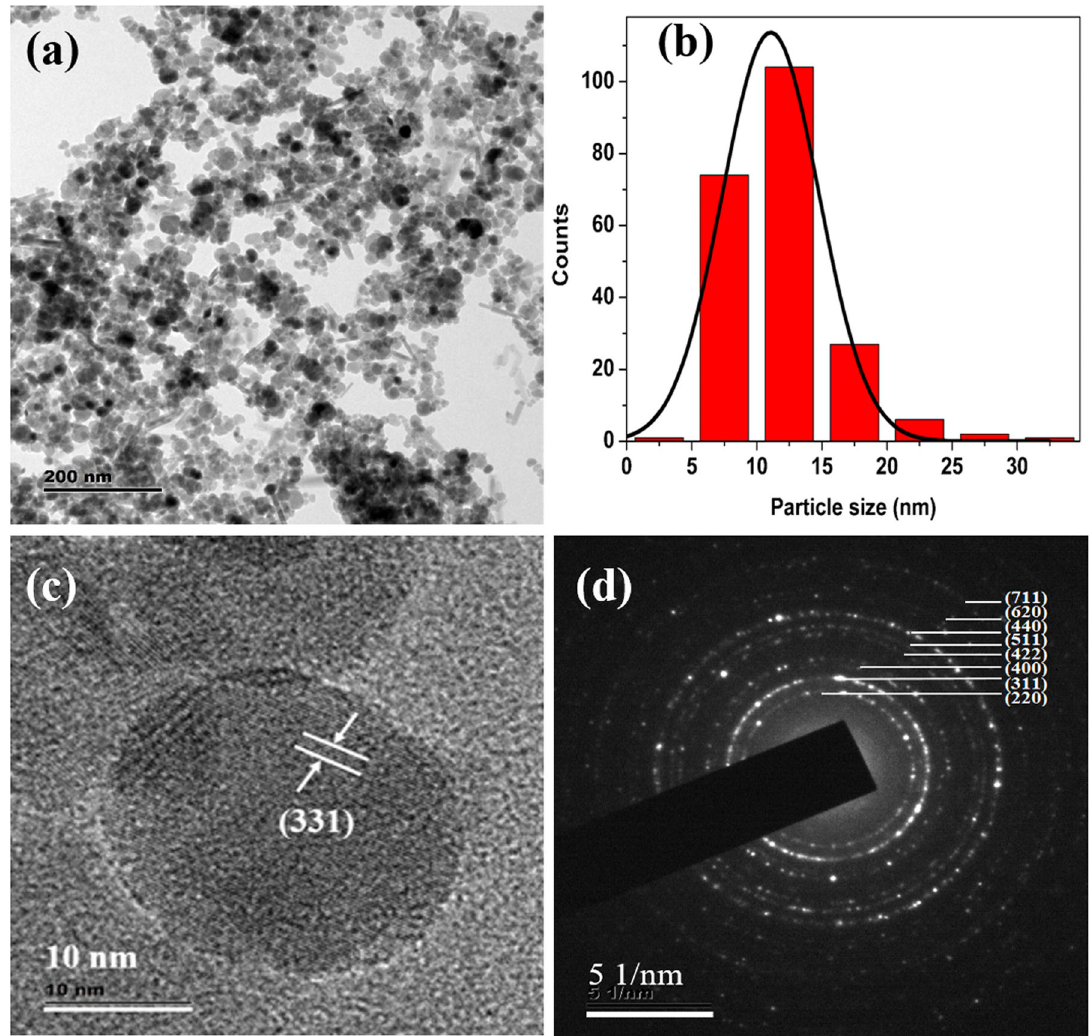
Fig. 2 a TEM image of Fe 3 O 4 , b Histogram of particle sizes obtained from TEM, c HRTEM image and d SAED pattern of Fe 3 O